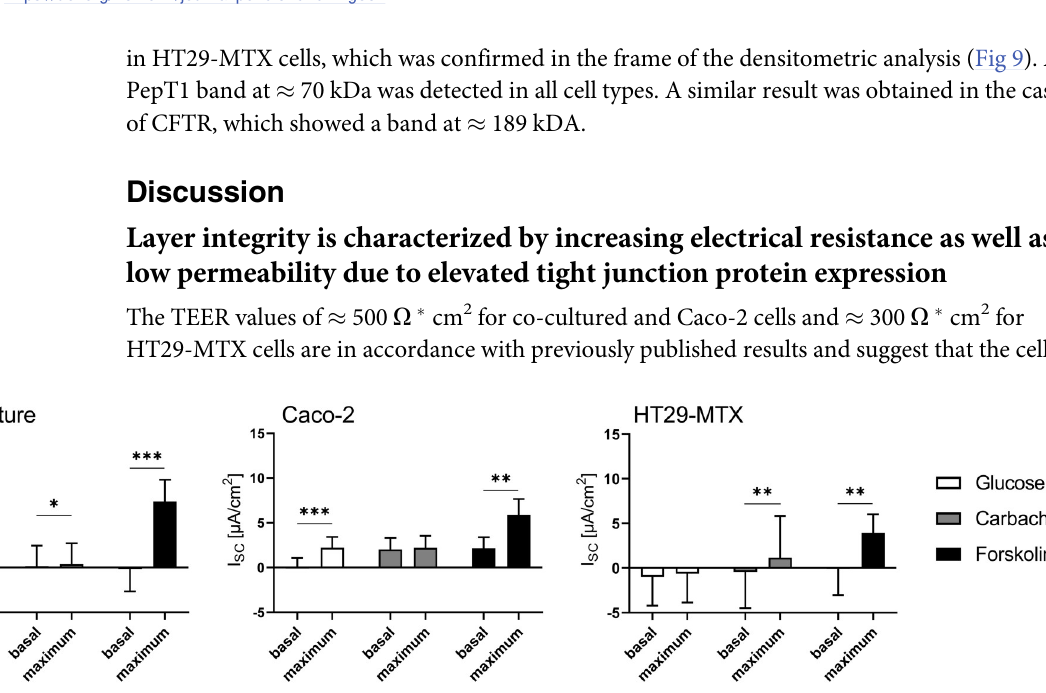
Fig 4. Cellular arrangement (cross sections) of cells grown on Snapwells 1 for 28 days. Cells were either stained with hematoxylin and eosin (H & E) or hematoxylin and PAS (H & PAS). Green triangles indicate cells with a large lumen, violet triangles indicate PAS- positive cells and black triangles indicate PAS-positive staining on top of PAS-negative cells. Representative figures are shown, chosen from three independent experiments with three technical replicates per cellular approach.